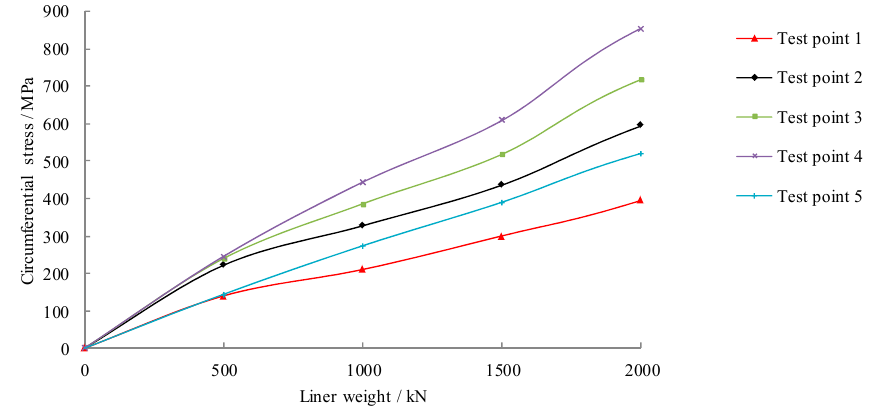
Figure 12. Circumferential stress of outer casing under liner weight.